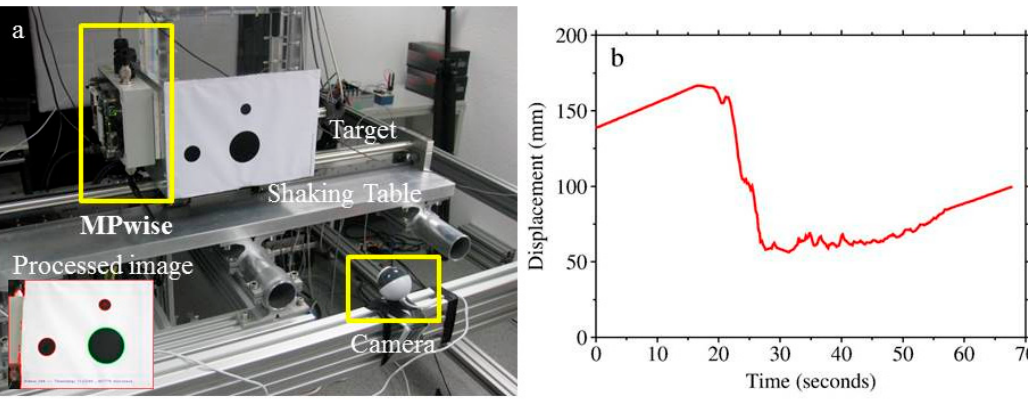
Figure 8. ( a ) The experimental set-up for the displacement measurements using a camera connected to a MPwise unit; ( b ) The displacement of the target point (red cross in the processed image in ( a ) as determined from the camera images.